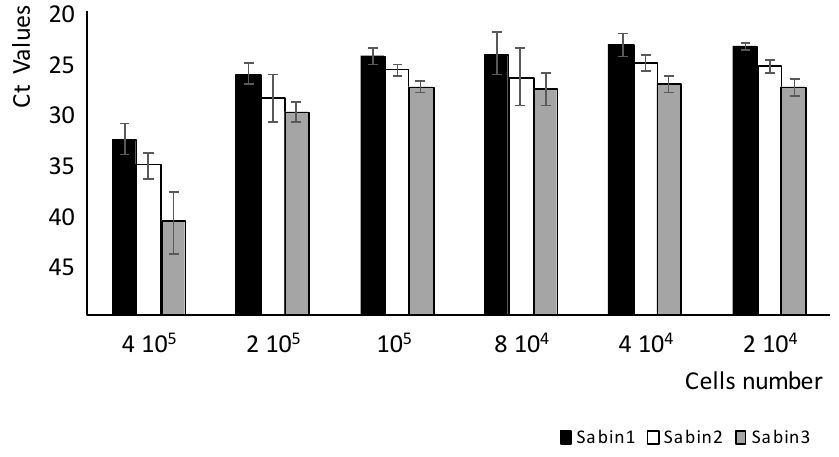
ff ect of cell numbers on Sabin strains Figure 2. Effect of cell numbers on Sabin strains quantitation. Figure 2. E Figure 2. Effect of cell numbers on Sabin strains quantitation.